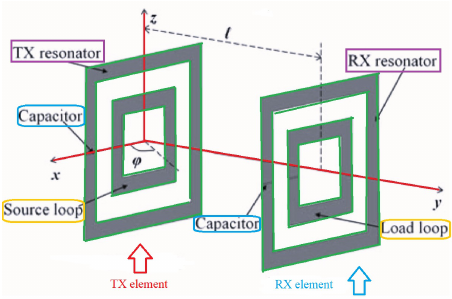
Figure 8. The configuration of the planar SCMR WPT system.